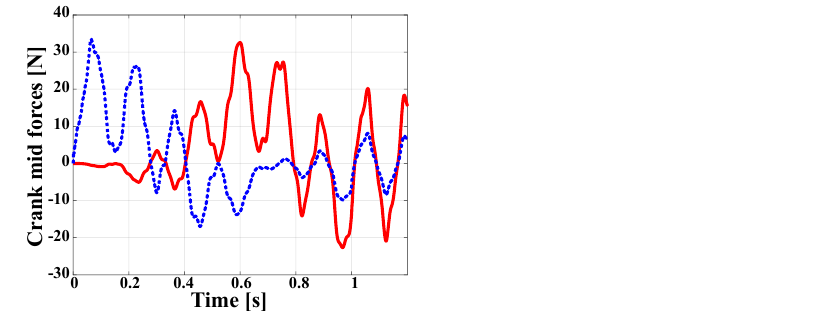
Figure 9. Mid-point crank forces: axial force (solid line), shear force (dotted line).